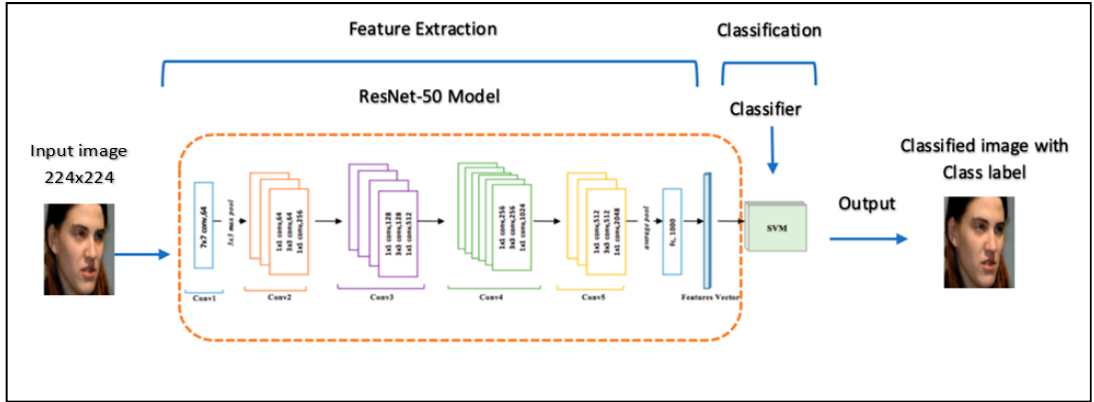
Figure 7. ResNet-50 convolutional neural networks with SVM.